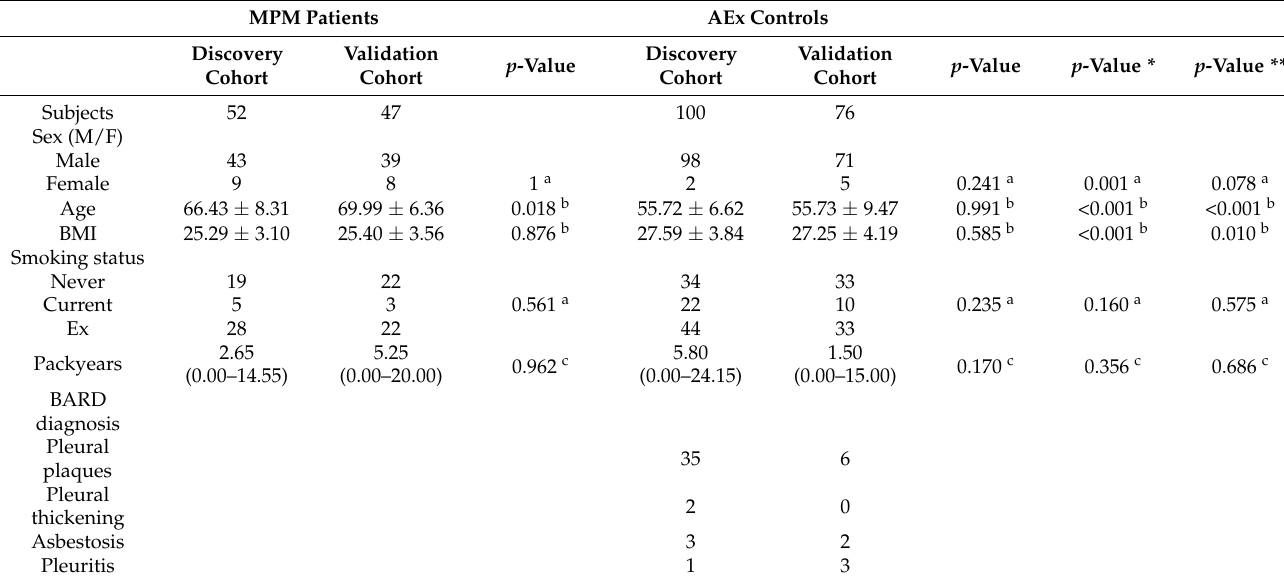
Table 2. Overview of the baseline clinical characteristics of the two participant classes in the discovery and validation cohort.